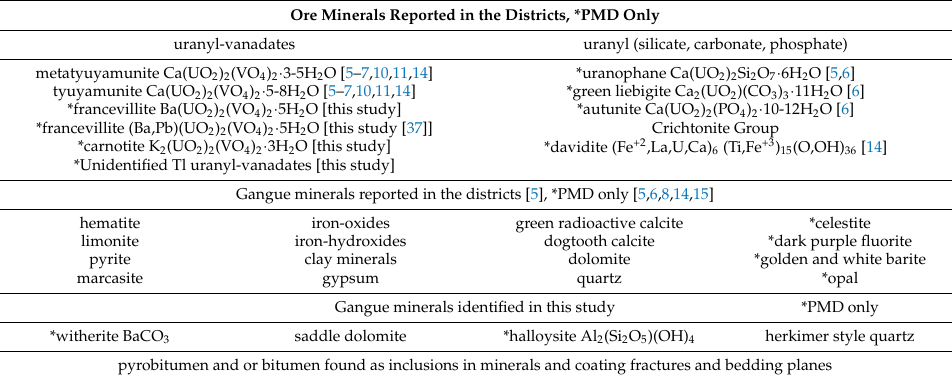
Table 1. Ore and gangue minerals reported in the literature and identified in this study for the Pryor Mountain and Little Mountain mining districts of Montana and